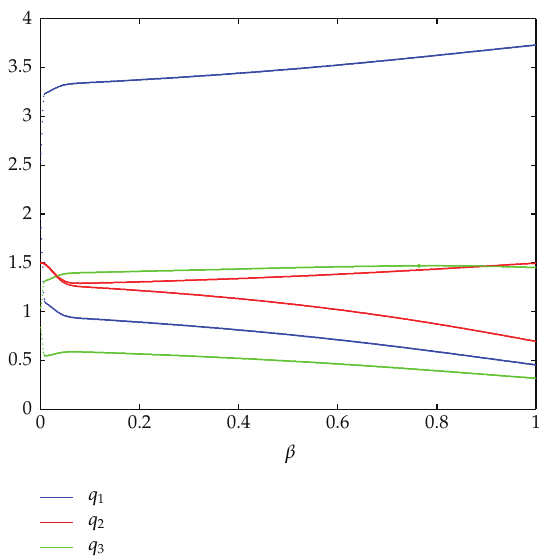
Figure 7: Bifurcation diagram with respect to β for α (cid:7) 20 . 0.